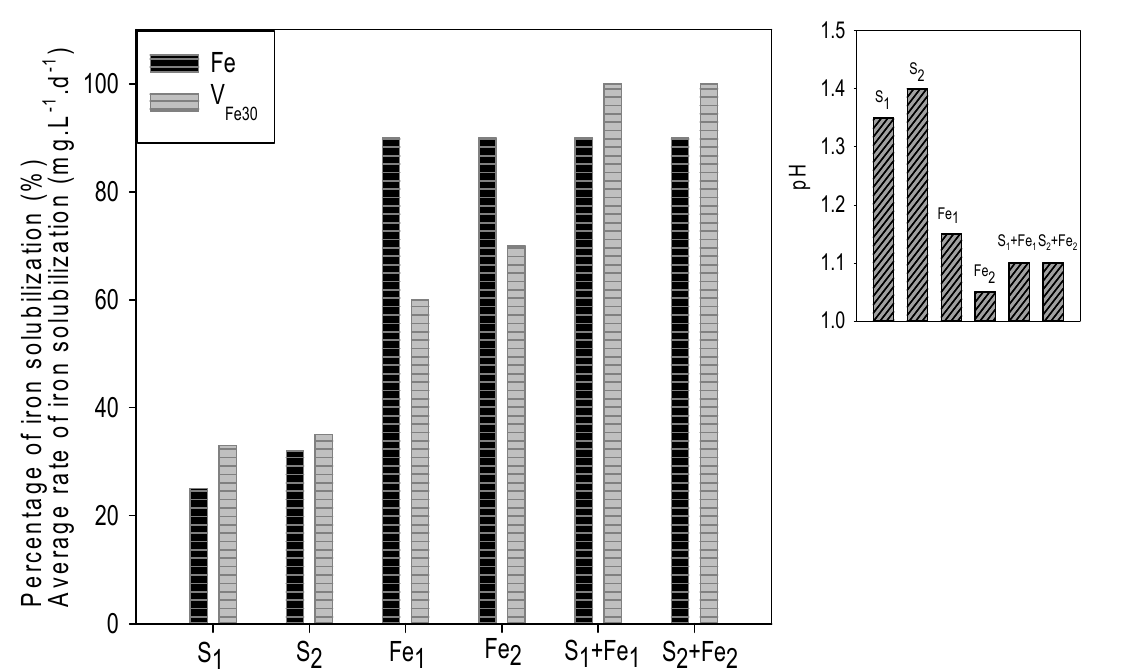
Figure 8. Biooxidation of DC2-5 sample using native consortia (pulp density: 5 % w/v). Rate of iron solubilization and percentage of iron solubilized (left) and final pH (right) after 120 days.